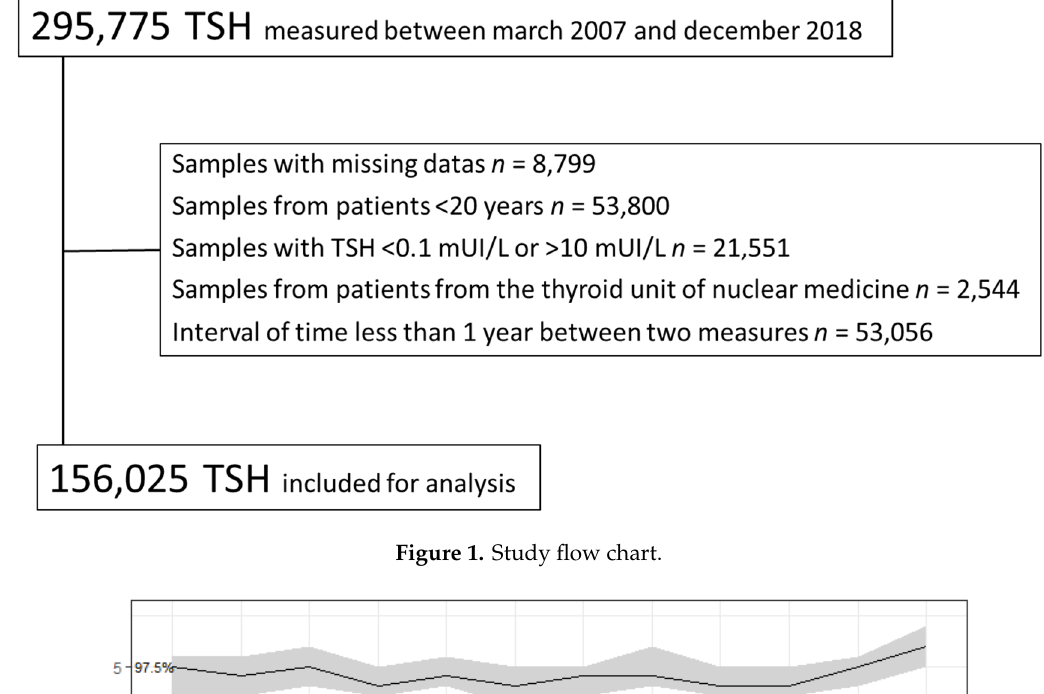
Figure 1. Study flow chart.